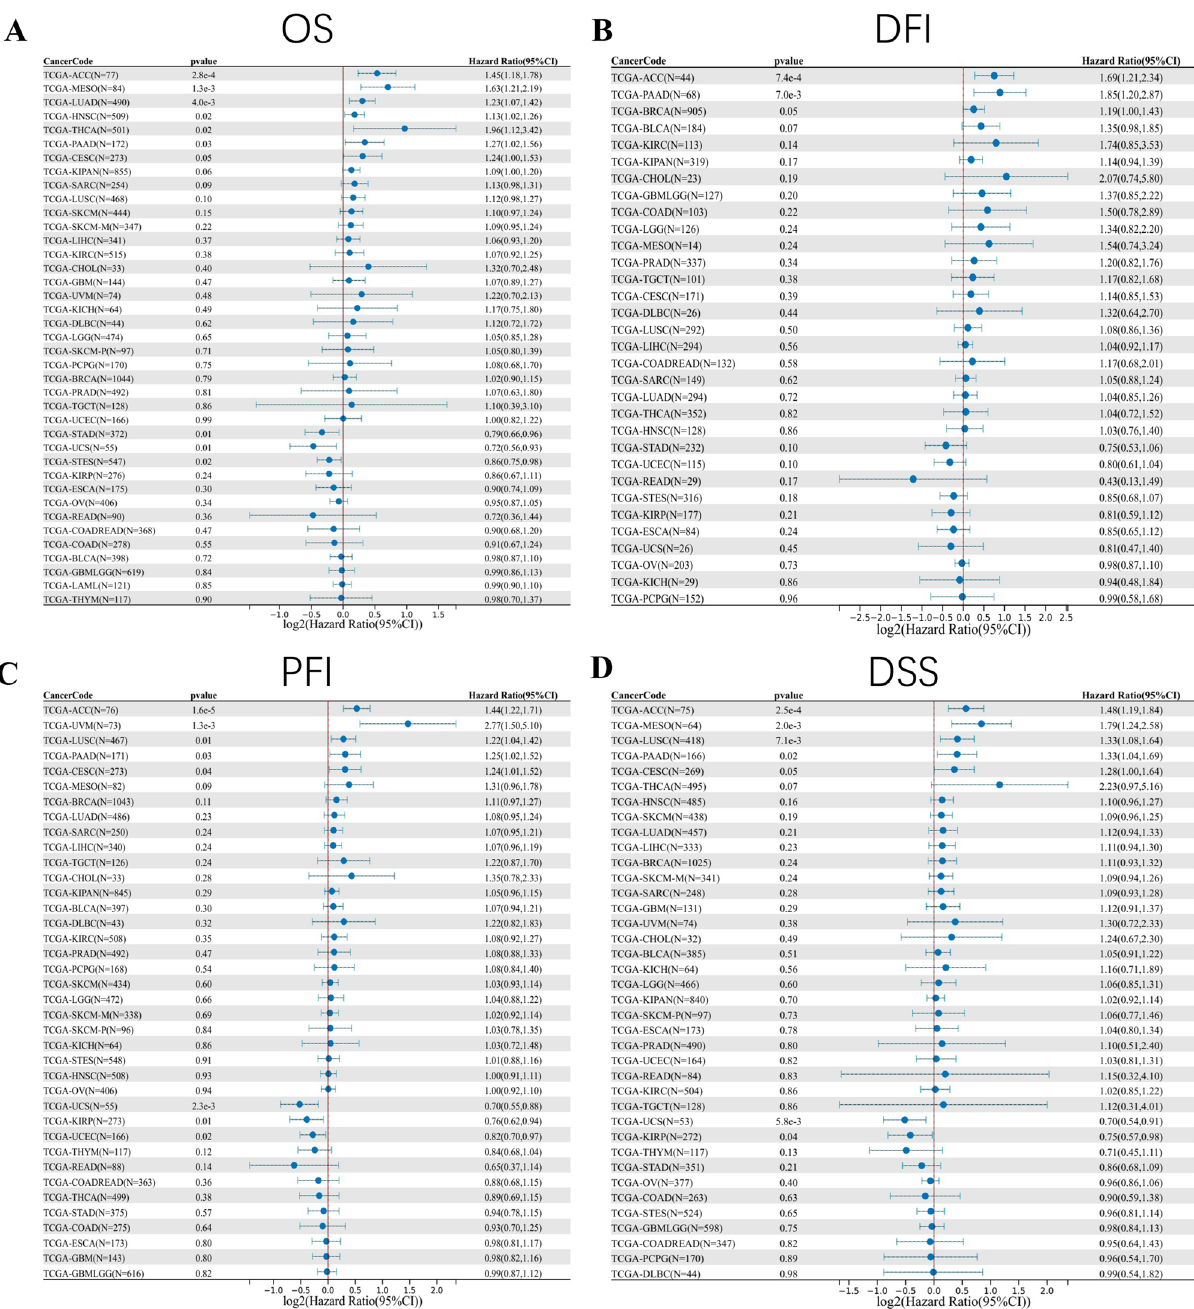
Figure 3. Sangerbox database analysis of the prognostic value of FAT1 mRNA expression in pan-cancer. ( A ) Overall survival. ( B ) Disease-free interval. ( C ) Progression-free interval. ( D ) Disease-specific